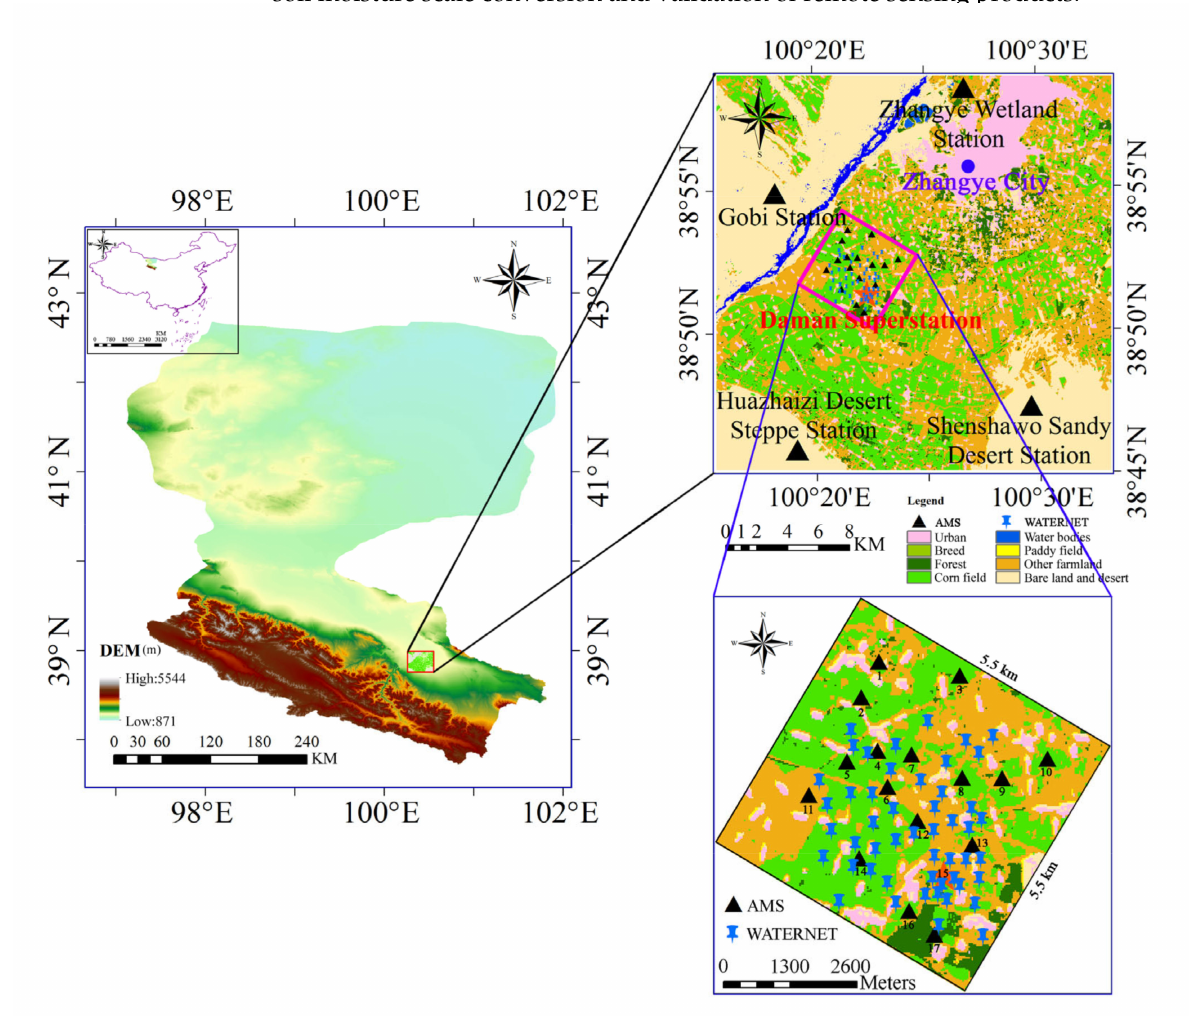
Figure 1. The location of the study area and the distribution of observation instruments (left is the HRB DEM, and right is the land use/land cover of 10 July